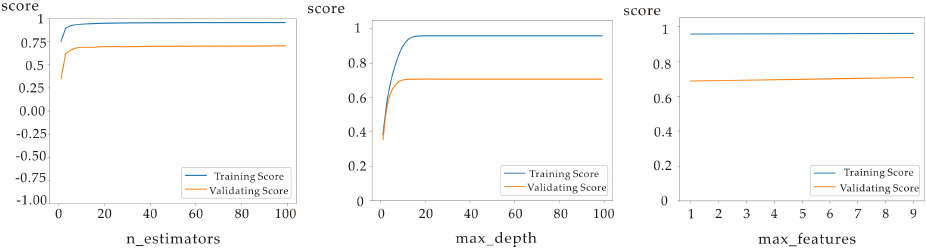
Figure 6. The process of adjusting the parameters for random forest (The score is the average score after 10-fold